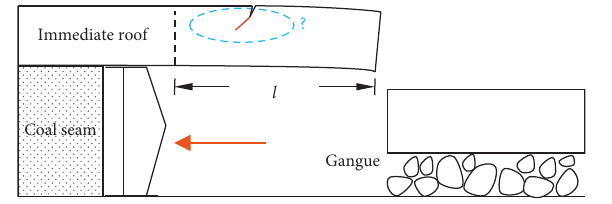
Figure 1: Roof periodic collapse in large mining height workface.